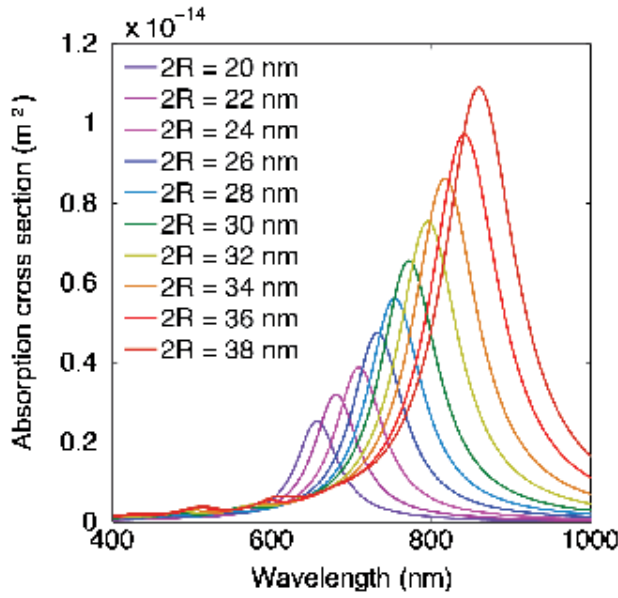
Figure 9. Full-field electromagnetic simulations of 50% Ag–50% Au alloy cuboidal HGN absorption cross section for a HGN wall thickness of 2 nm for various edge lengths. Decreasing the ratio of wall thickness to edge length red-shifts the spectra. Increasing the edge length increases the magnitude of the adsorption cross section as ~ R 2 t , as suggested by the analytic Mie theory (Equation (5)). Adapted from [45], published by Wiley, 2018.